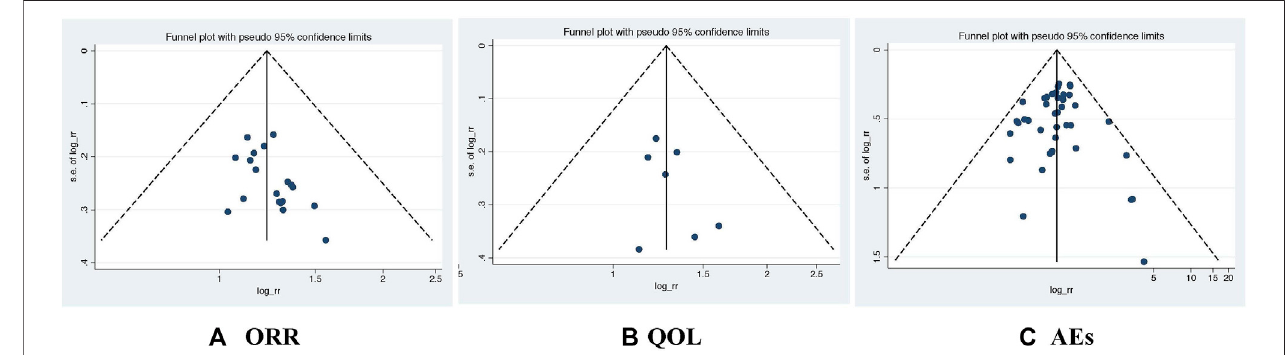
FIGURE 6 | The shape of the funnelplot appeared to be approximately symmetrical. ORR, Objective response rate; QOL, Quality of life; AEs, Adverse events.